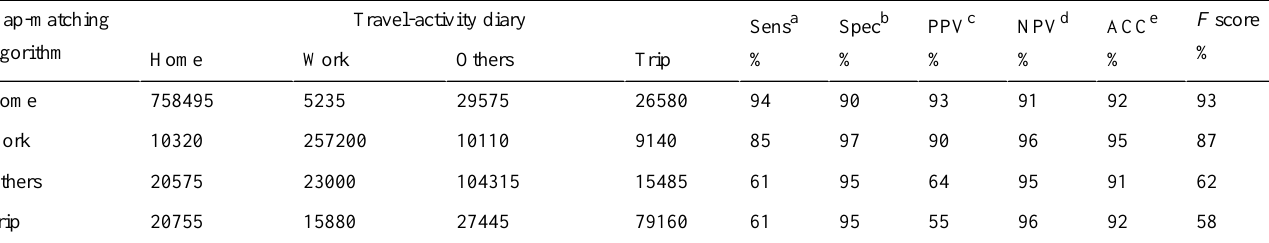
Table 3. Travel-activity confusion matrix between the travel-activity diary and our map-matching algorithm and its interrelationship statistics (cluster defined as 150 m; Gwet agreement coefficient AC1=81%).